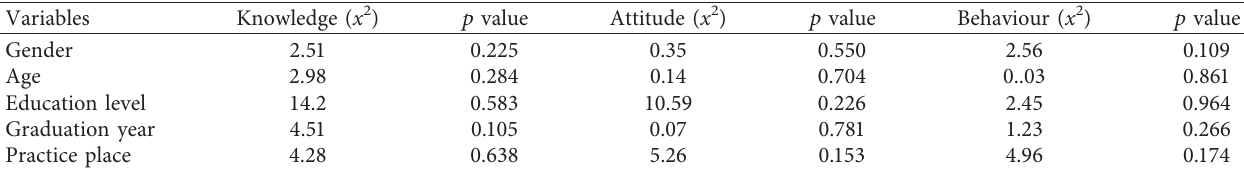
Table 6: Analysis of the influence of gender, age, year of graduation, place of practice, and education level on knowledge, attitudes, and behavior of dentists about